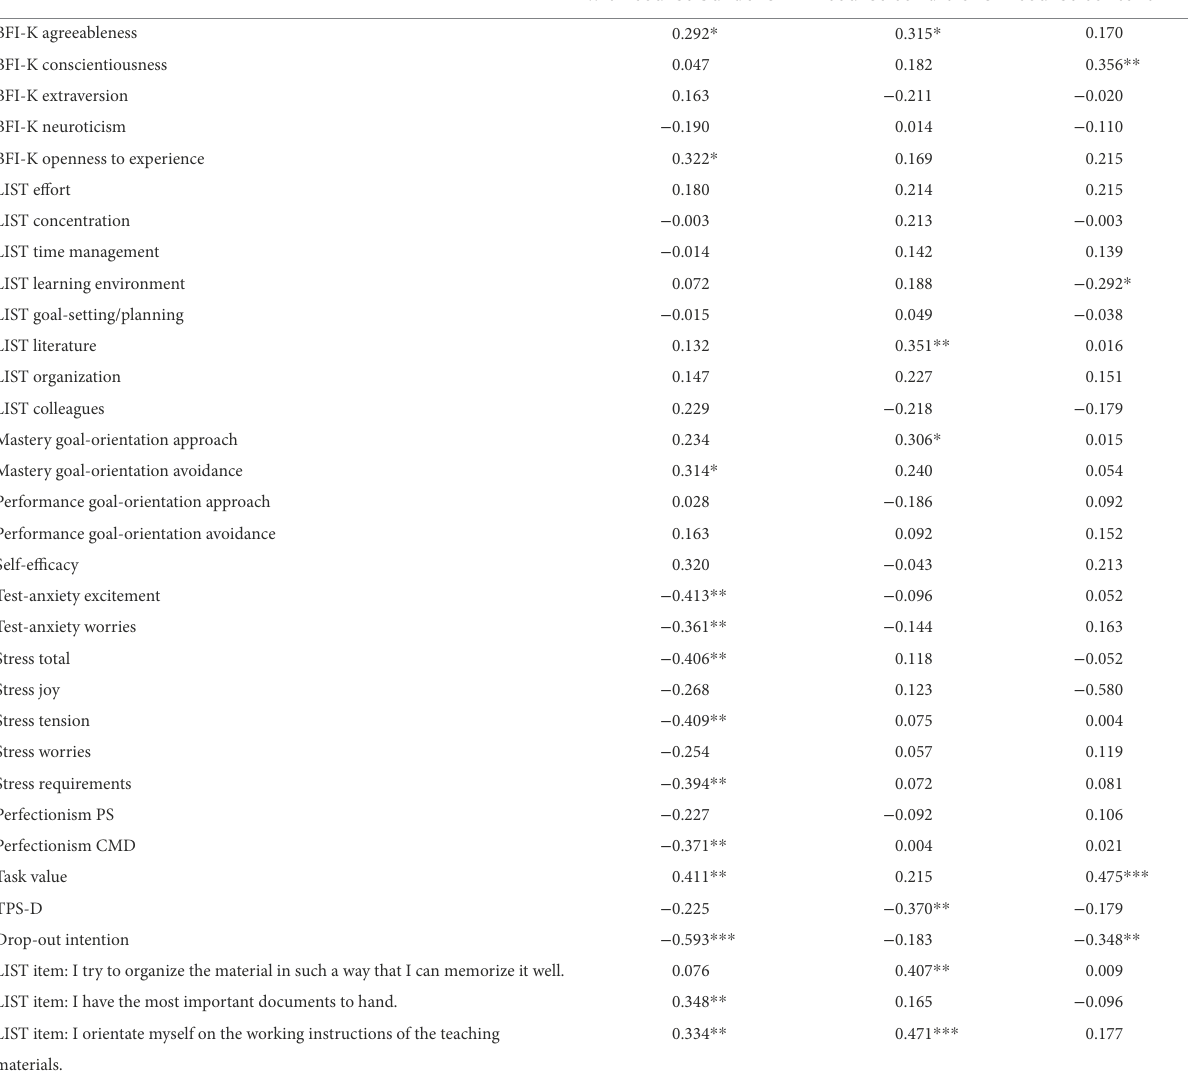
TABLE 3 Correlations between indicators of potential e-learning readiness dimensions (inventories) and course satisfaction as a criterion for learning success.